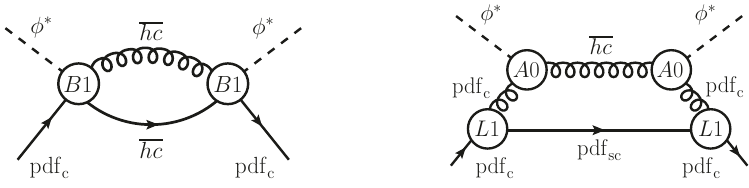
Figure 4 . SCET representation of the content of (3.35) for quark-Higgs scattering at NLP as x 1. Wilson lines are set to !